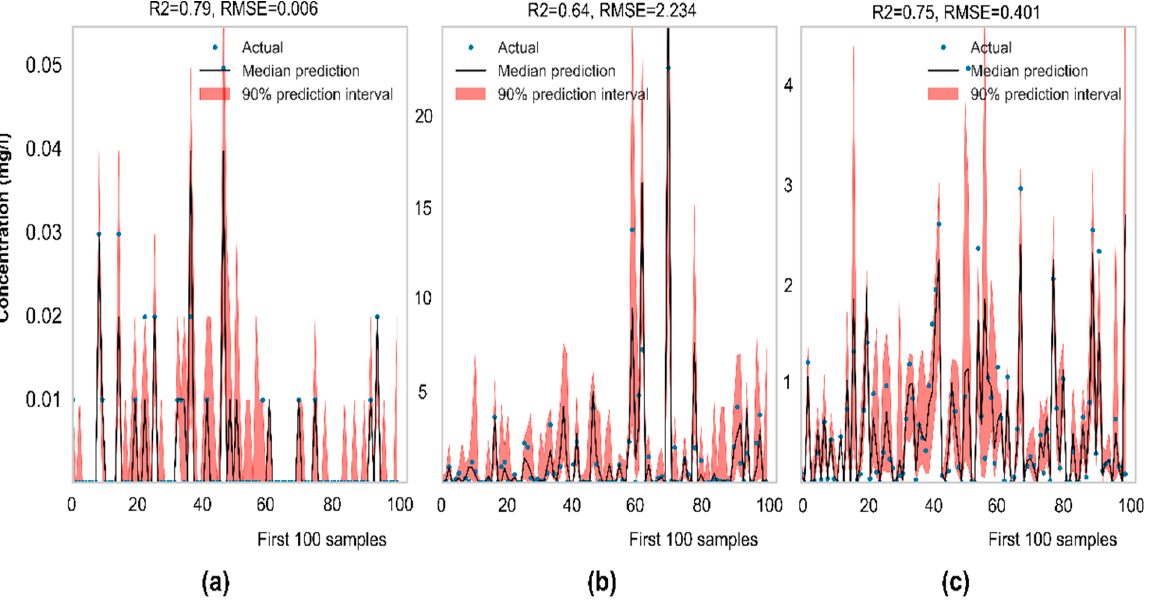
Figure 11. Visualization of observed data, median prediction line, and interval prediction by low- cost features: ( a ) As model, PICP = 97.97%, MPI = 0.015; ( b ) Fe model, PICP = 77.13%, MPI =